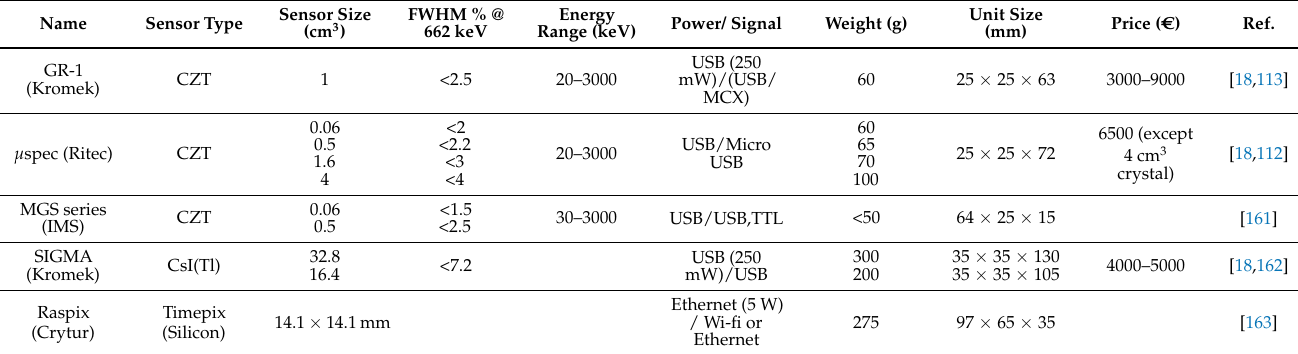
Table 5. Selection of commercially off-the-shelf (COTS) lightweight spectrometers with potential for use in mobile